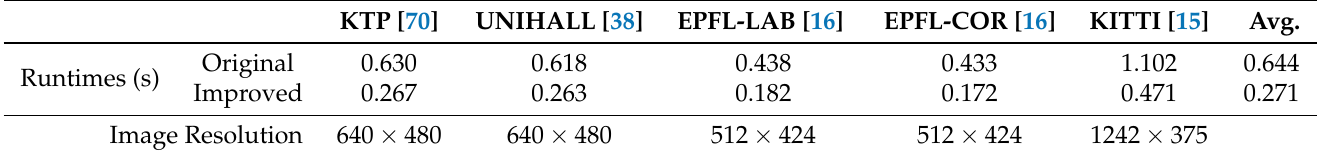
Table 3. HHA encoding times of our improved and original methods on five datasets.